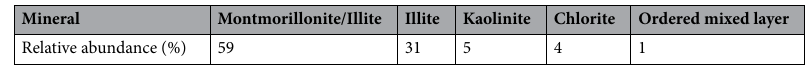
Table 2. Mineralogy of soft marine clay used in this study.